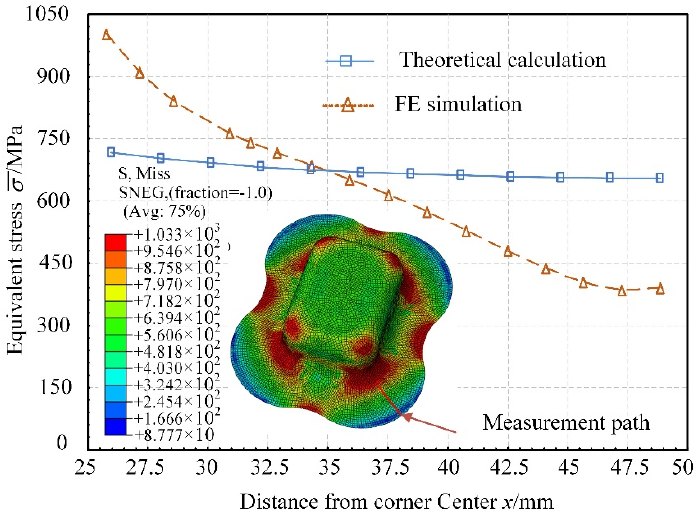
Figure 10. Equivalent stress distribution in the corner